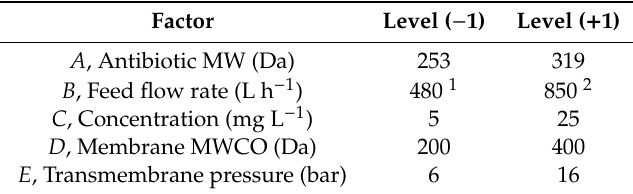
Table 2. Factors and levels investigated during the 2 5 factorial design. MW: molecular weight, MWCO: molecular weight cut-o ff